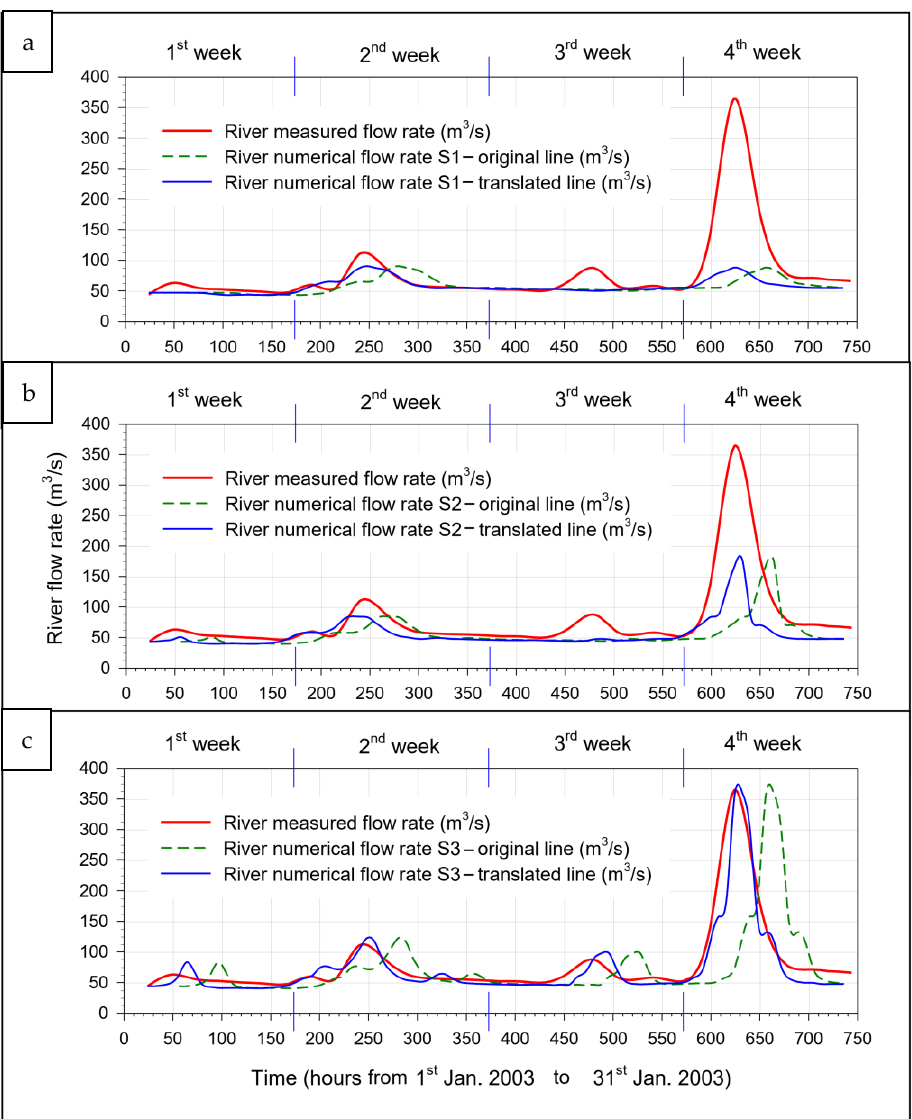
Figure 4. Comparison plots between measured and numerical river flow rate data at S. Teresa station; red line: river measured flow rate; dashed green line: original numerical river flow rate; solid blue line: translated numerical river flow rate; ( a ) simulations: S1 ( k = 0.00115, final Infiltration rate f c = 1.94 · 10 − 6 ; initial Infiltration rate f 0 = 1.41 · 10 − 5 ); ( b ): S2 ( k = 0.00115, f c = 2.78 · 10 − 7 , f 0 = 2.78 · 10 − 8 ); ( c ): S3 (downstream area k = 0.00115, f c = 2.78 · 10 − 8 , f 0 = 2.78 · 10 − 9 , upstream area, k = 0.00115, f c = 1.816 · 10 − 8 , f 0 = 1.816 · 10 − 9 ); Manning’s number M =